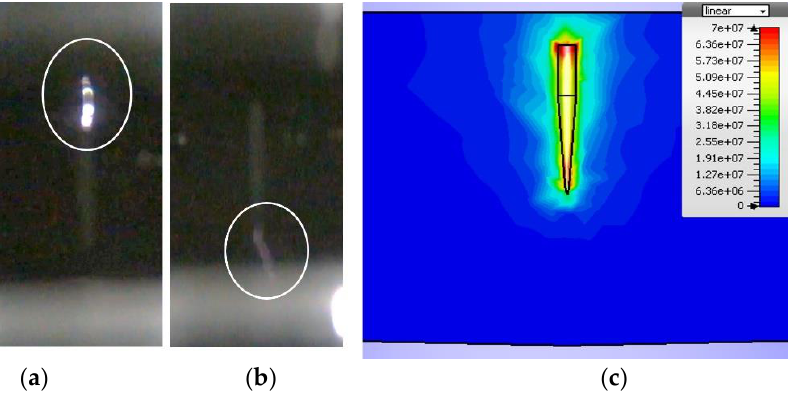
Figure 14. Corona for 10 mm of particle size and d = 8 mm at voltage stress of 60.3 kV: ( a ) corona at the bottom of particle; ( b ) corona at the top of particle; and ( c ) simulation result of E -field distribu- tion.